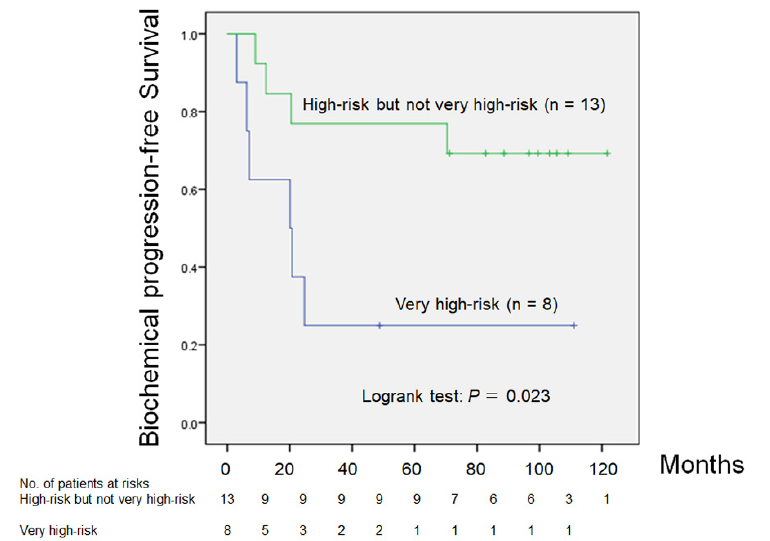
Figure 2. Comparison of biochemical progression-free survival between patients with high risk, but not very high risk PCa versus patients with very high risk PCa ( p = 0.023).